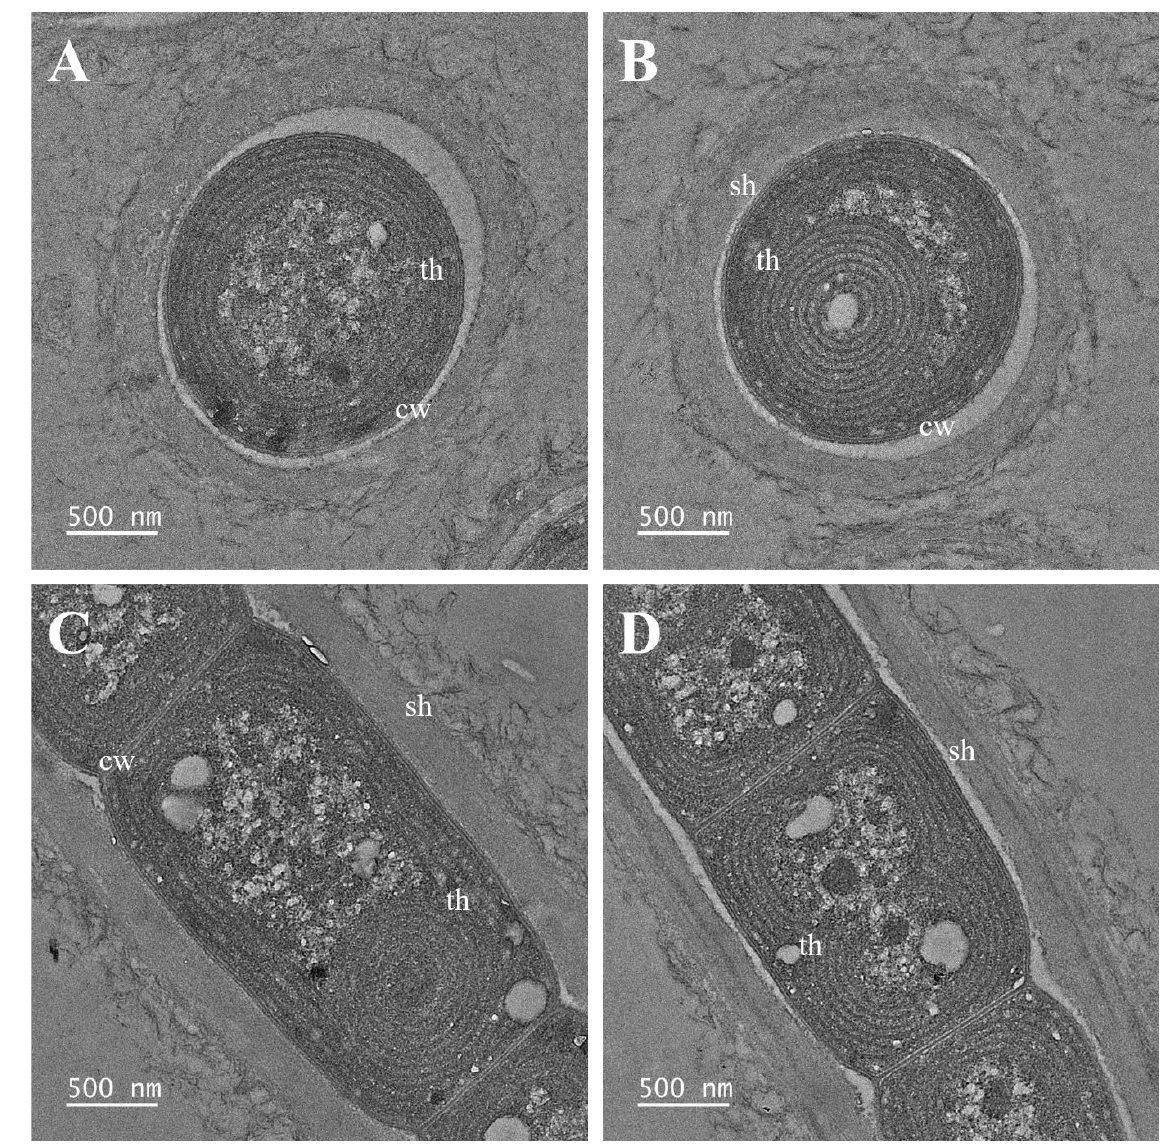
Figure 7. Transmission electron micrographs of Plectolyngbya salina strain FBCC-A1477. ( A , B ) Parietal thylakoids seen in the cross section. ( C , D ) Parietal thylakoids appearing in the longitudinal section. cw: cell wall; sh: sheath; th: thylakoids.